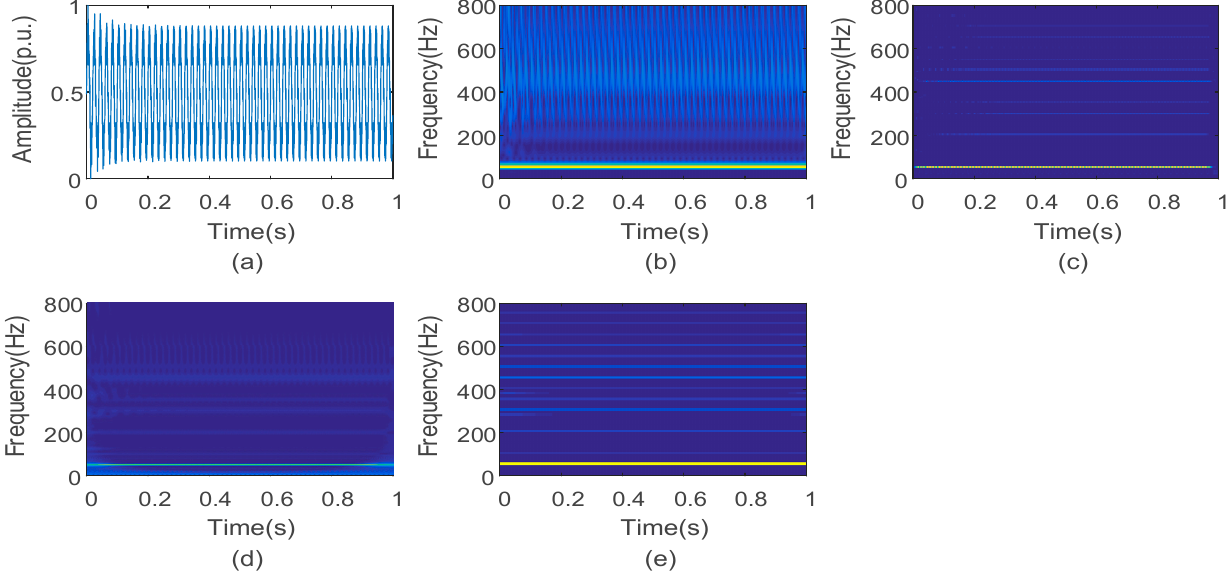
Figure 6. The time-frequency spectra of photovoltaic grid-connected harmonic signals based on three methods. ( a ) Simulation signal, ( b ) S-transform, ( c ) synchrosqueezing STFT (SSTFT), ( d ) WT, ( e ) synchrosqueezing adaptive S-transform (SAST).